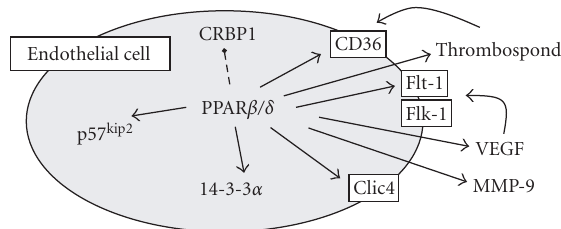
Figure 1: Proangiogenic/prosurvival pathways of PPAR β / δ in en- dothelial cells. PPAR β / δ is expressed in endothelial cells. PPAR β / δ activation induces (solid line) the expression of VEGF and its re- ceptor Flt-1, matrix metalloproteinase (MMP)-9, thrombospondin and its receptor CD36, the chloride intracellular channel protein (CLIC)-4, the cell cycle inhibitor p57 kip2 , and the antiapoptotic pro- tein 14-3-3 α . In contrast, the cellular retinol binding protein-1 is de- creased (dashed line) by PPAR β / δ activation. For those interested, a complex transcriptional map of the potential role of PPAR β / δ as a hub node in tumour angiogenesis has recently also been formed as detailed in